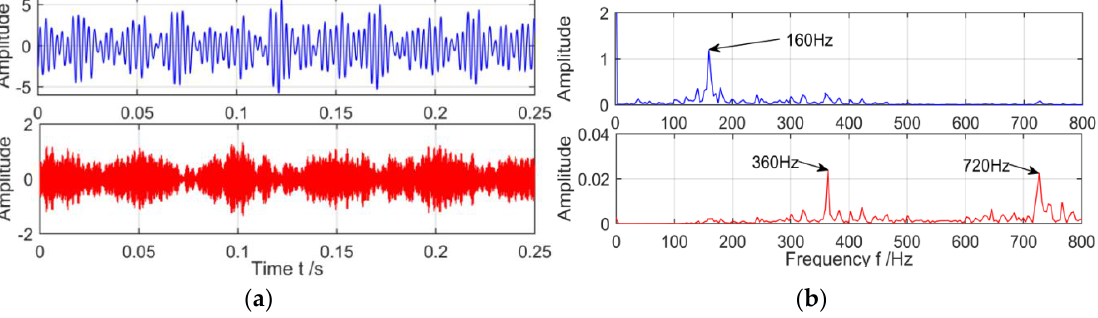
Figure 13. The spectrum of IMFs after MVMD decomposition and its corresponding spectrum. ( a ) Time domain of IMFs after MVMD of vibration signal; and ( b ) The spectrum corresponding to each layer of IMF.